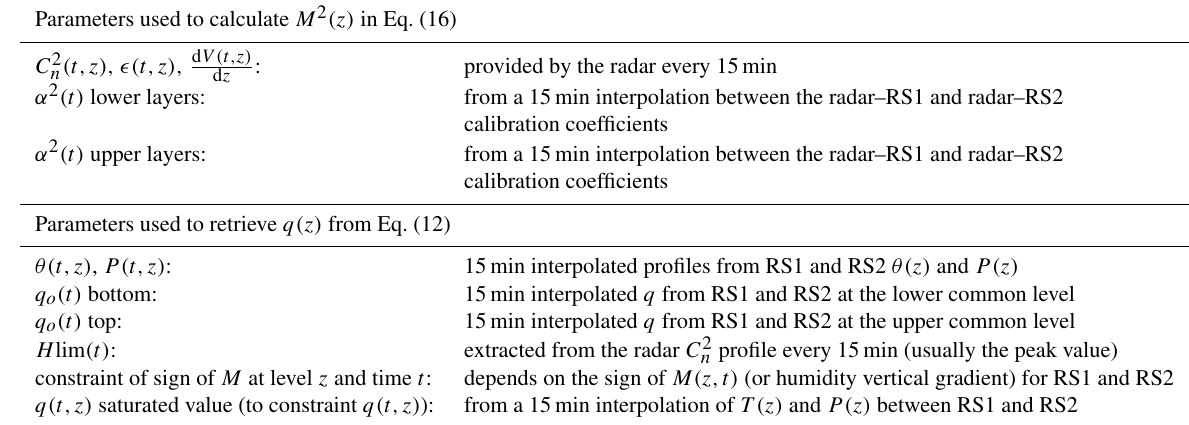
Figure 5. (a) α 2 calibration coefficients obtained with the BLLAST dataset in low mode as a function of the stratification estimated with the gradient Richardson number. The results are divided into the lower (circles) and upper part (squares) of the ABL and shown as a function of the time of the day (colored scale). (b) Scatterplot of the calibration coefficients α 2 (high level versus low level) obtained with the BLLAST and HyMeX datasets in low mode. The crosses correspond to the profiles measured during the potentially dry convective period, i.e., 09:30–17:00UTC. Table 2. Parameters used to retrieve 15min spaced vertical profiles of q in the time interval between two radiosoundings RS1 and RS2. Hlim serves to apply the convenient calibration coefficient and to merge the two